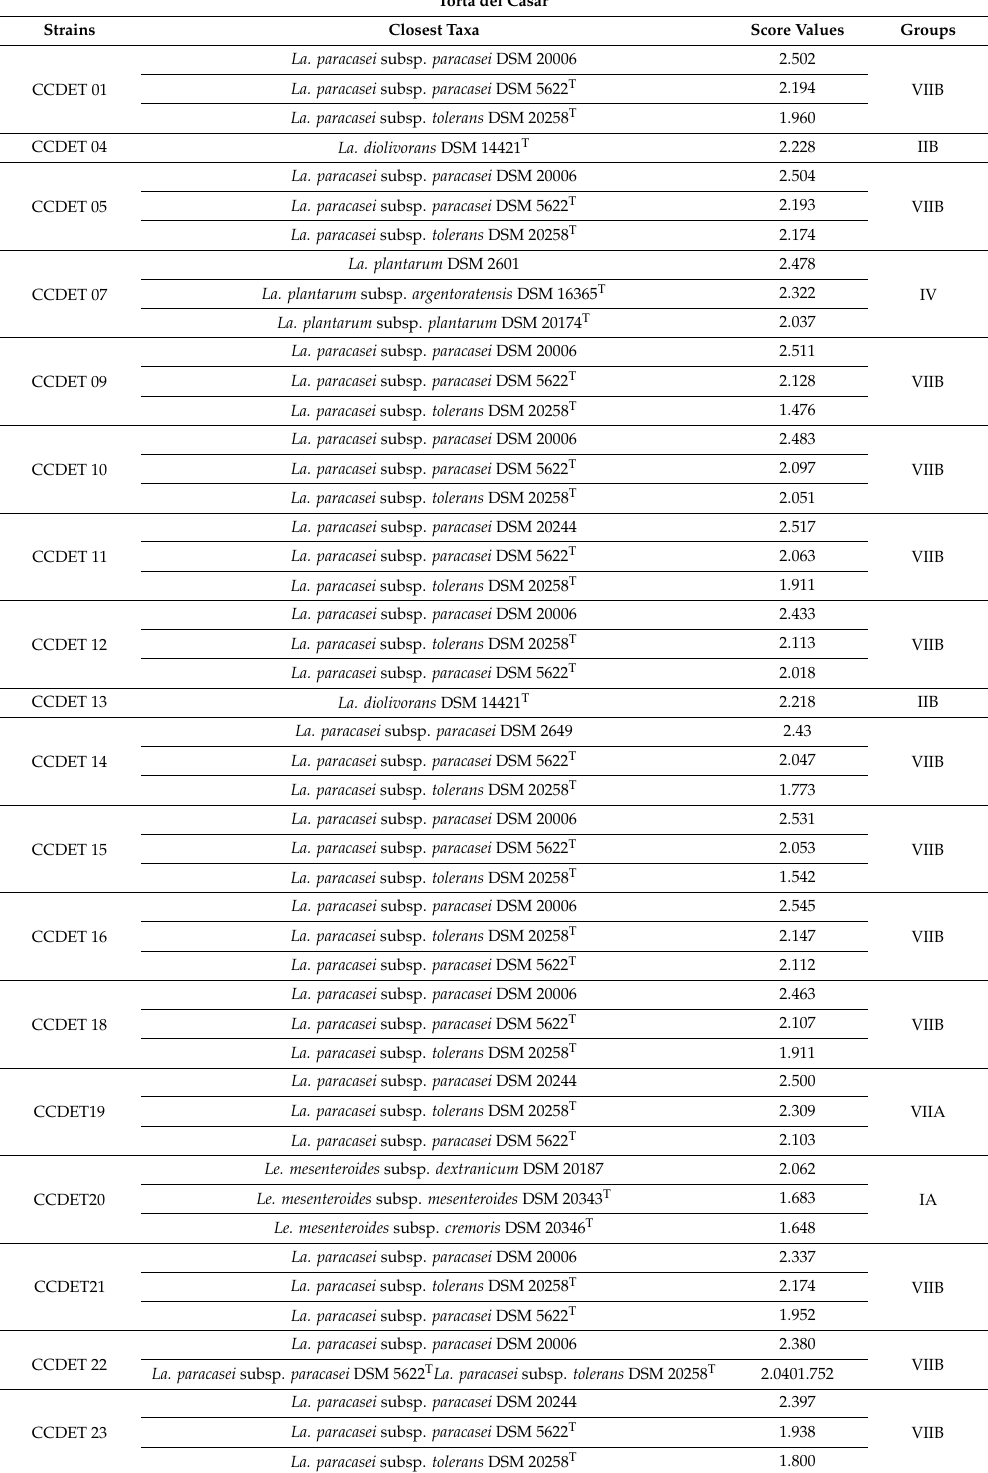
Table 1. Results obtained using MALDI-TOF MS